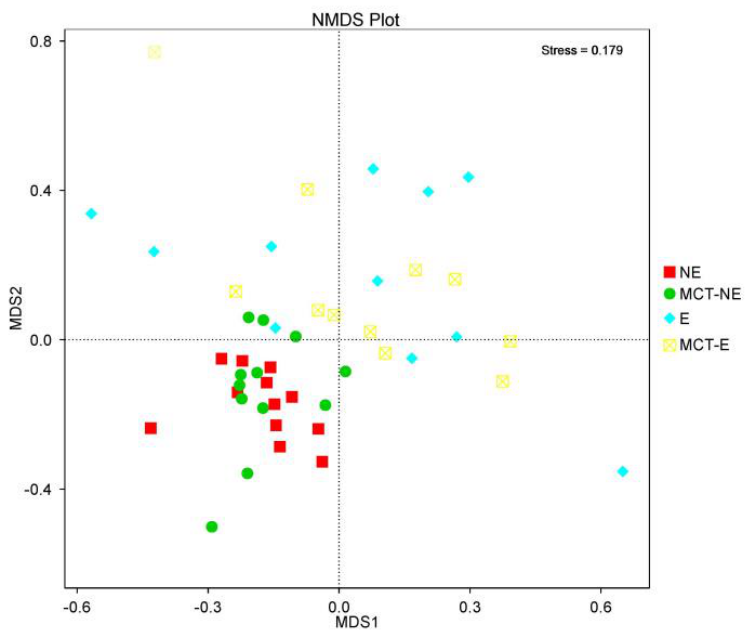
Figure 2. Non-metric multidimensional scaling (NMDS) plots showed that epileptic (E) and non- epileptic (NE) dogs were two distinct clusters before and after the MCT diet.